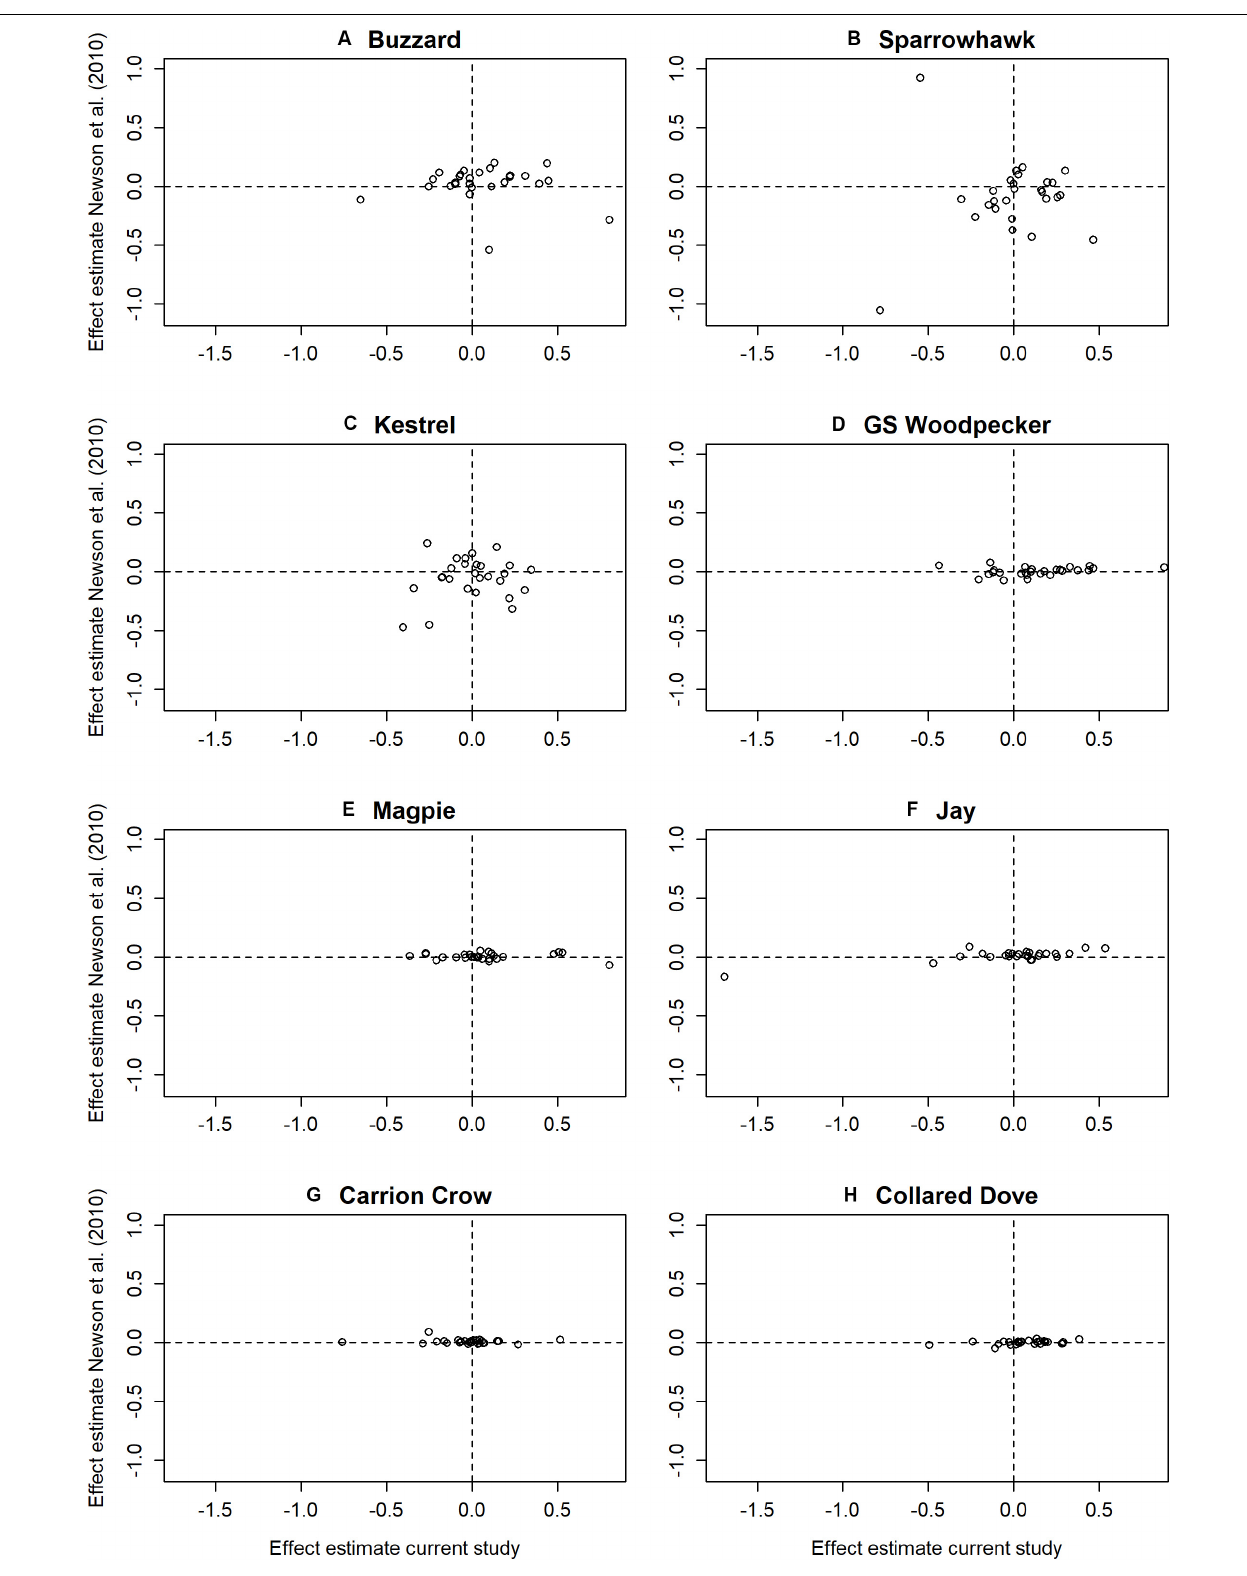
FIGURE 5 | Plots of estimated predator effects on individual prey species from Newson et al. (2010) against equivalent estimates from the current study. Plots (A–H) show estimated effects of individual predator species on prey species covered by both studies.